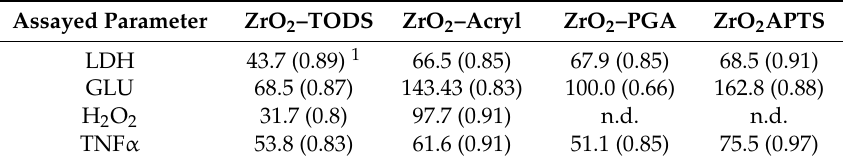
Figure 4. Dose-dependent effects of the four differently coated ZrO 2 NPs on NR8383 alveolar macrophages in vitro. Cultures of 3 × 10 5 cells per well of a 96-well plate were laden with either ZrO 2 -Acryl, ZrO 2 -APTS, ZrO 2 -TODS, or ZrO 2 -PGA and incubated for 16 h. Culture supernatants were assessed for ( a ) activity of lactate dehydrogenase (LDH) in percent of triton X-100 lysed control cells, ( b ) activity of glucuronidase (GLU) in percent of triton X-100 lysed control cells, ( c ) extracellular H 2 O 2 in percent of the zymosan-treated positive control, and ( d ) tumor necrosis factor α (TNF alpha), as indicated by the lysis of L929 fibroblasts. Values are means ± SD from three independent experiments; Level of untreated controls (CTL) is indicated by solid lines; concentration values were corrected according to post hoc gravimetric measurements (see Methods section). Values from ZrO 2 -Acryl and ZrO 2 -TODS were taken from [8]. Table 2. EC50 values of in vitro effects on NR8383 cells.